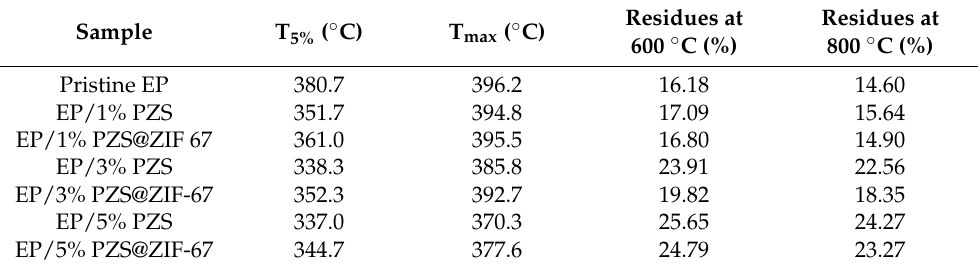
Table 2. TGA detailed data of EP and its composites.